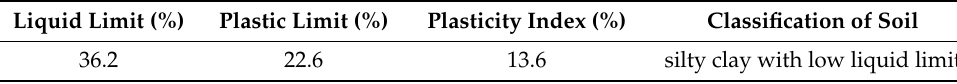
Table 2. Liquid limit and plastic limit test